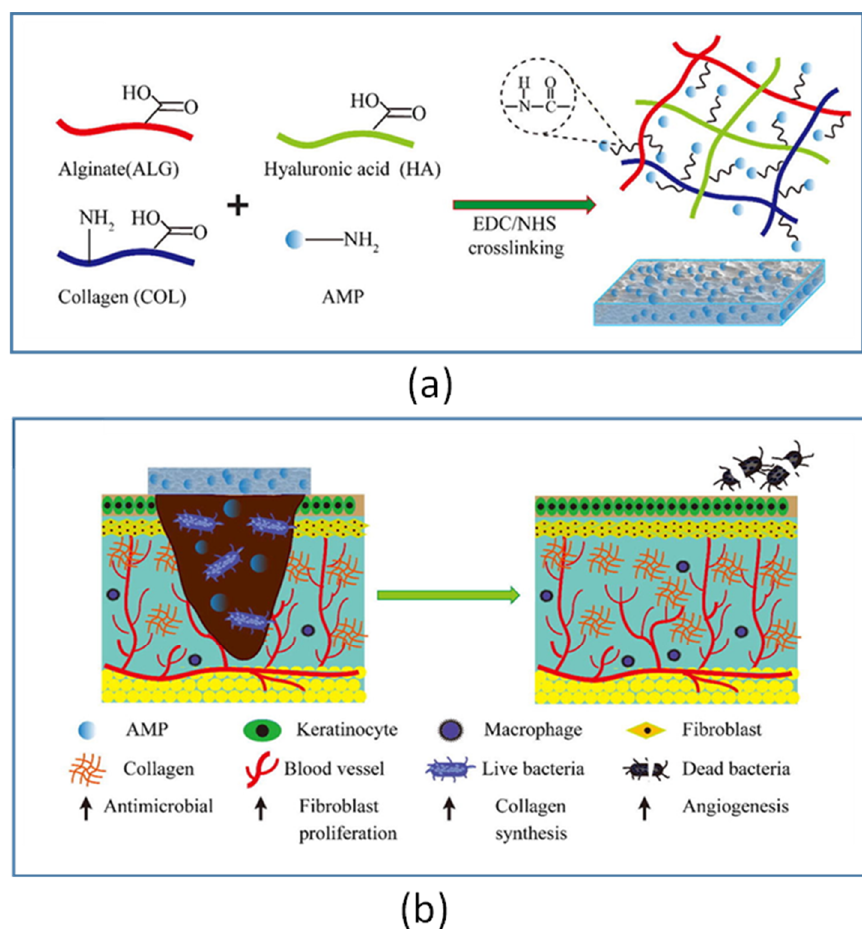
Figure 3. Main steps of the preparation of the ALG/HA/COL-Tet213 wound dressings. ( a ) The AMP Tet213-conjugated ALG/HA/COL wound dressings were prepared using the chemical reaction between the carboxyl groups and the amino groups on ALG, COL, HA, and Tet213; EDC: 1-ethyl-3-(3-dimethylaminopropyl)-carbodiimide; NHS: N-hydroxysuccinimide. ( b ) Multiple biological activities of the Tet213-conjugated ALG/HA/COL. Reproduced from Ref. [53] with permission, with slight modifications.